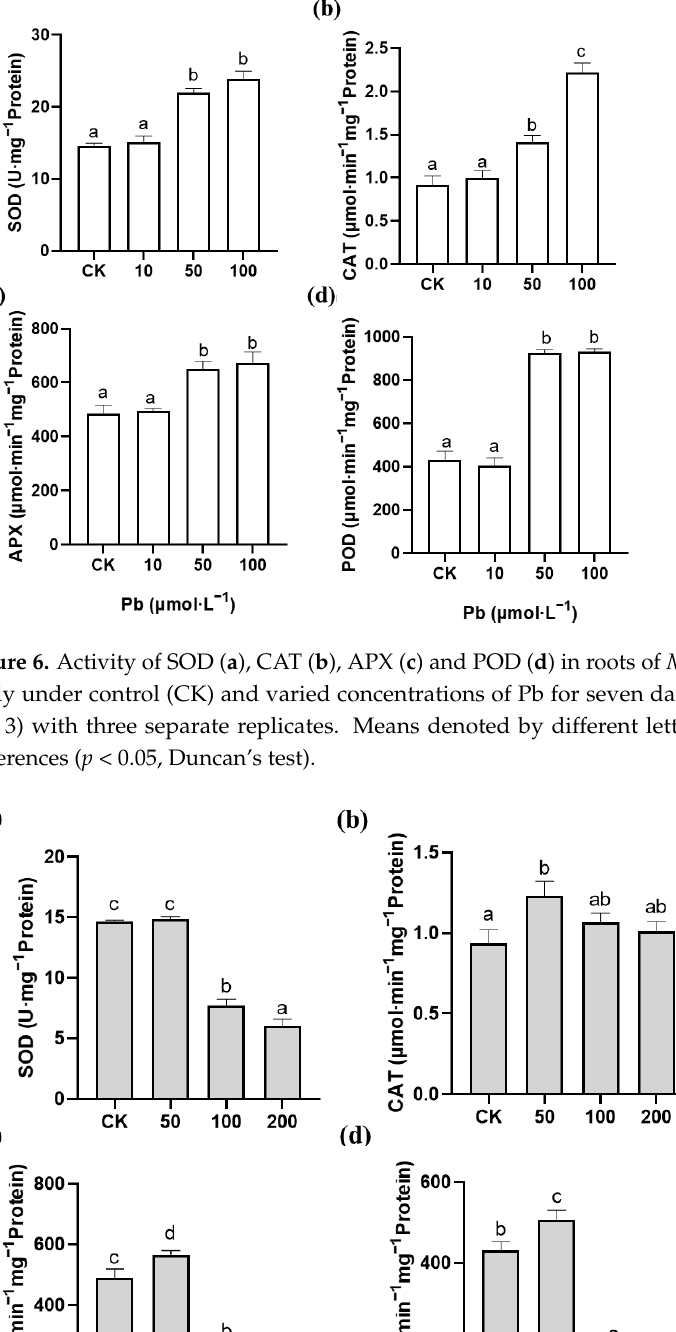
Figure 5. Activity of NADPH oxidase in roots of M. cordata grown hydroponically under control (CK), 100 μmol· L −1 Pb (Pb100) and Zn (Zn100) for seven days . Values are means ± SE ( n = 3) with three separate replicates. Means denoted by different letters refer to the significant differences ( p < 0.05, Duncan’s test).